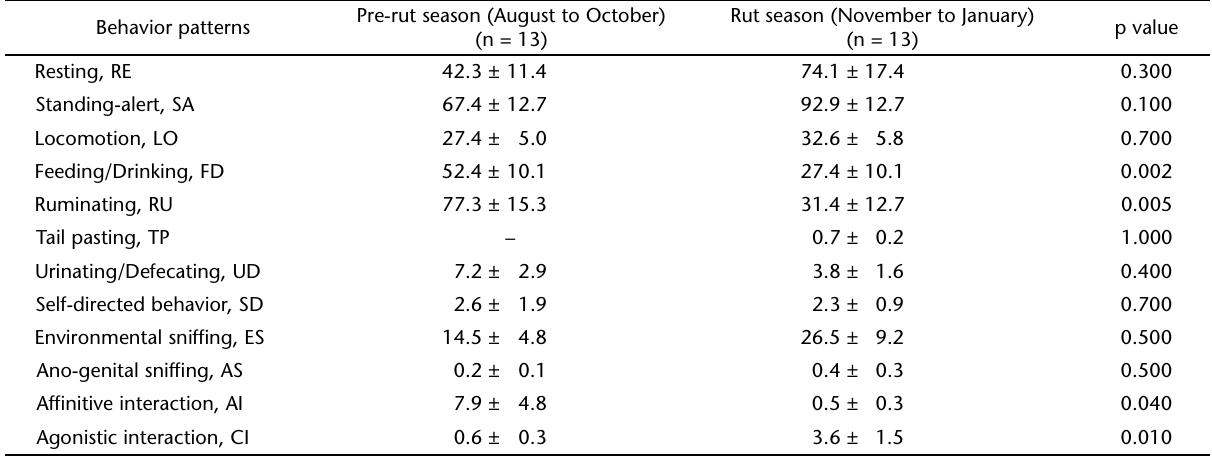
Table I. Average duration of female musk deer behavior patterns (seconds ± S.E.) from 2005 to 2006 in the Xinglongshan Musk Deer Farm of China. Behavior